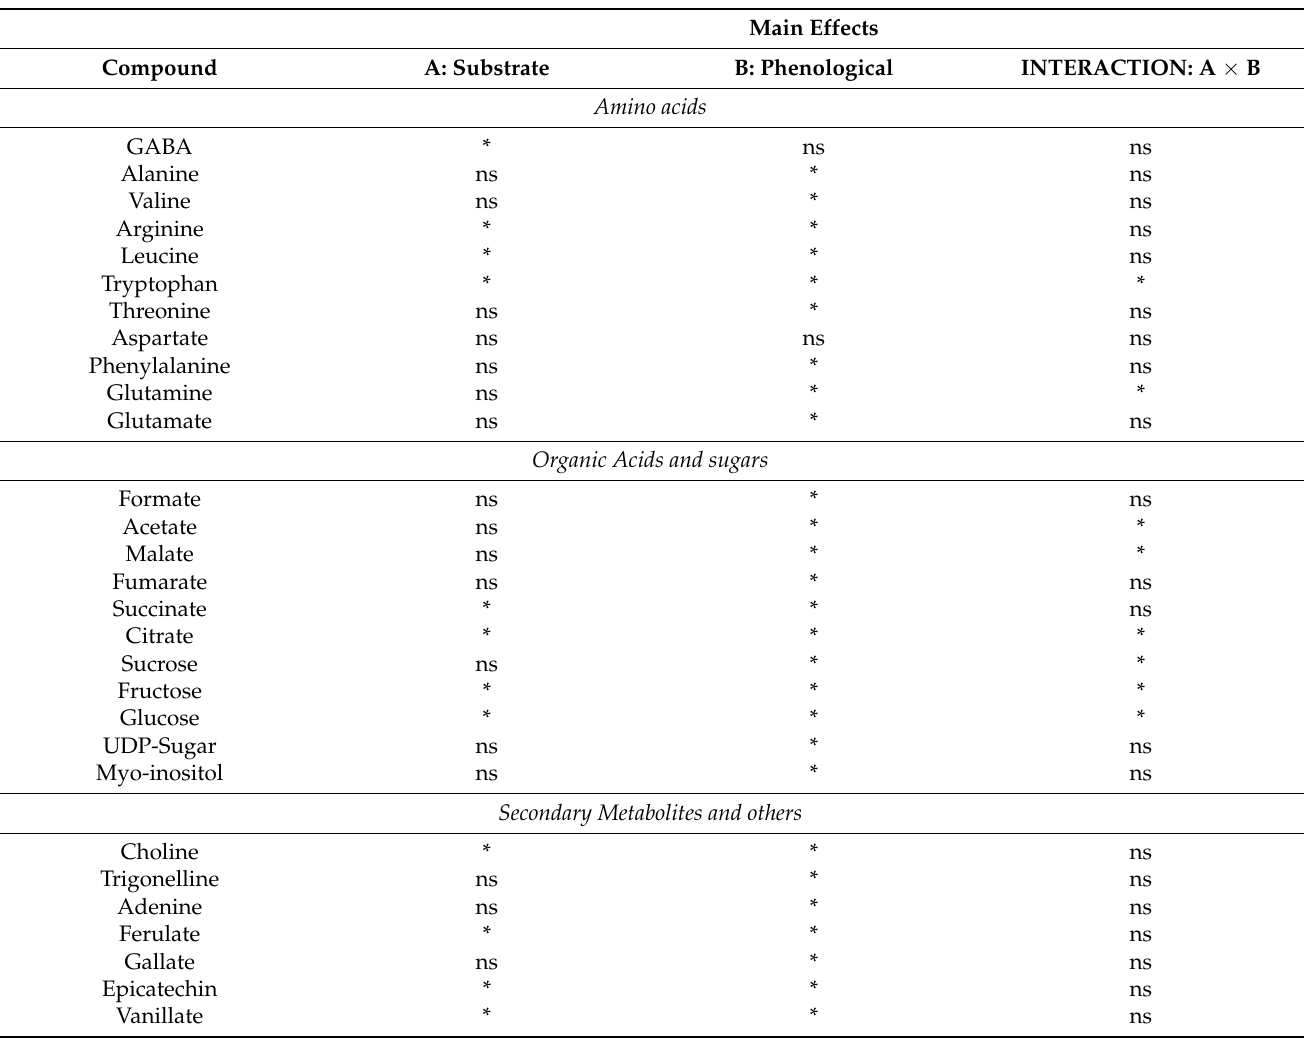
Table 2. General ANOVA results for the metabolomic leaves analysis, where the compounds with * presented significant differences and “ns” (not significative) were